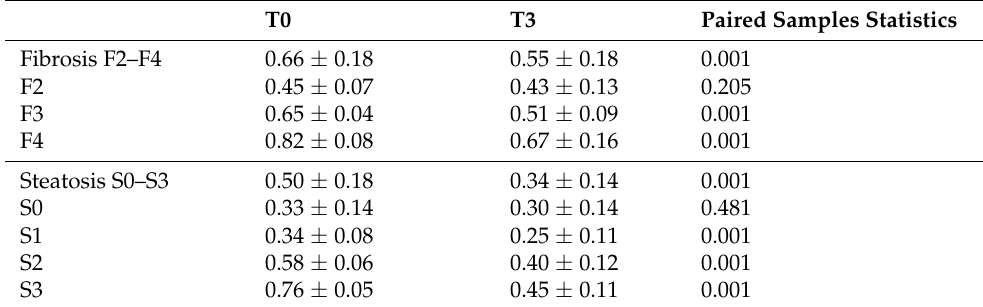
Table 3. Evolution of fibrosis and steatosis three months